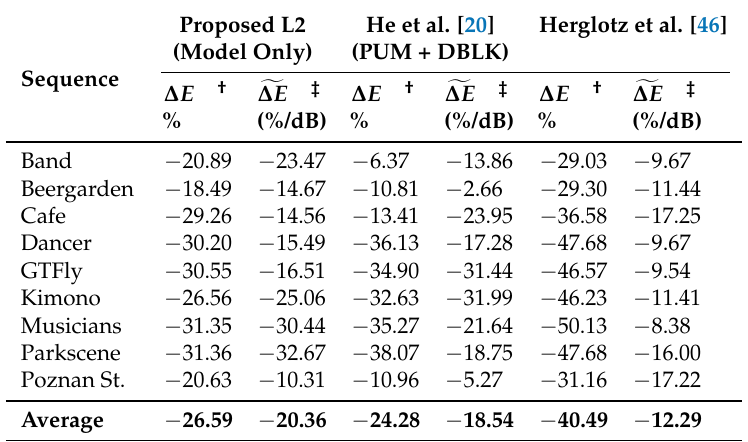
Table 6. Decoder energy reduction performance on a RISC-based ARM CPU